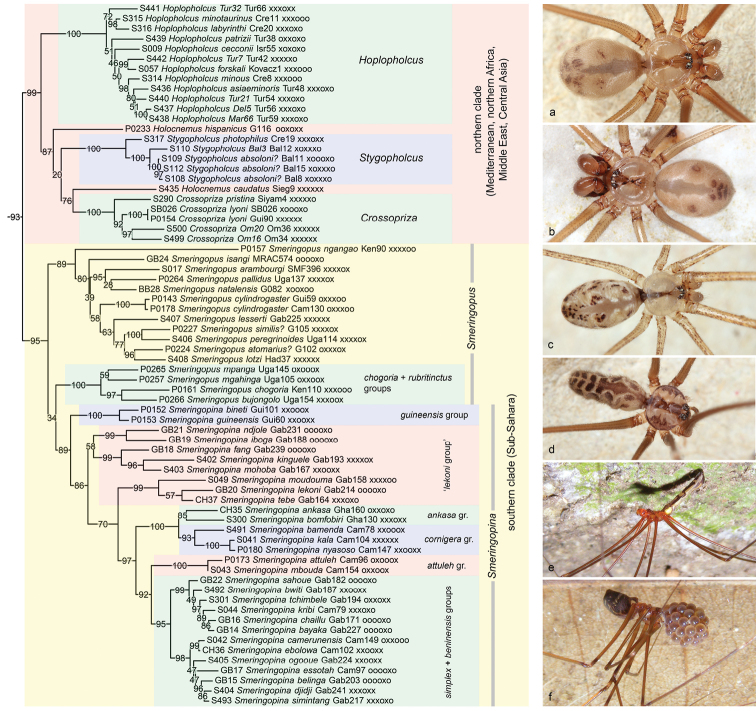
Smeringopinae aHoplopholcus sp. n. “Mar66” (Turkey) bStygopholcusabsoloni? (Bosnia and Herzegovina) cCrossopriza sp. n. “Om11” (Oman) dSmeringopuspallidus (Philippines) eSmeringopinapulchra (Ghana) fSmeringopinaankasa (Ghana).